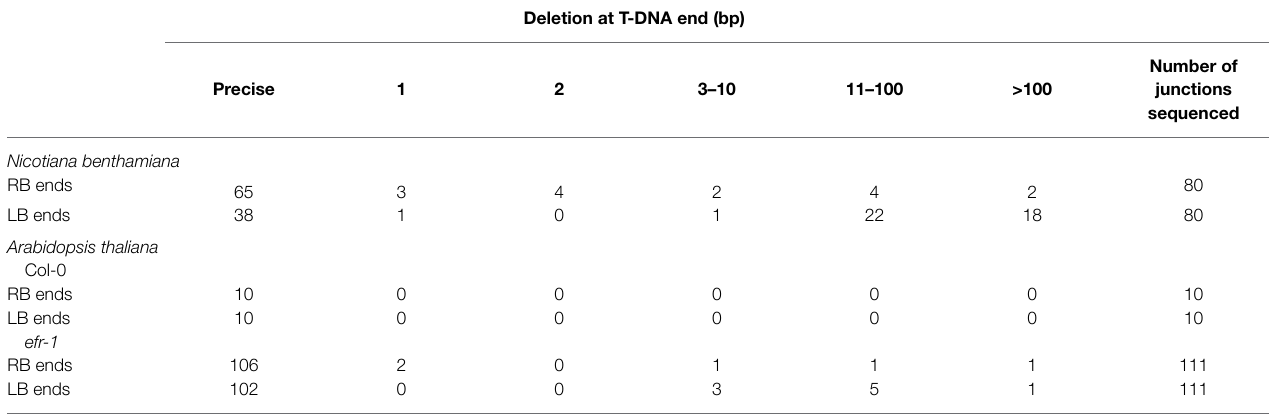
TABLE 1 | Summary of extent of deletions at the RB and LB ends of RB-LB junctions of monomeric T-circles from Nicotiana benthamiana and Arabidopsis thaliana infected with EHA105. Deletion at T-DNA end